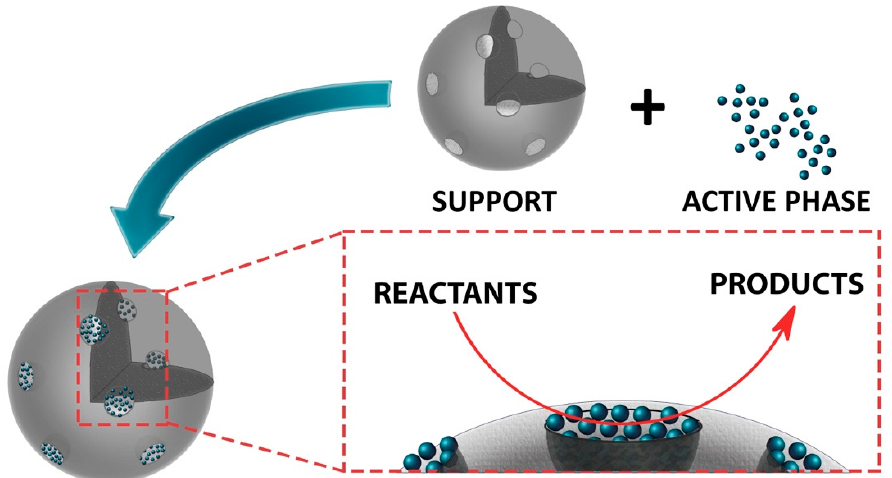
Figure 12. Example for hybrid nanoparticles in reaction environment, in which the particle itself acts as support for smaller clusters on the surface which are active in the catalytic processes.